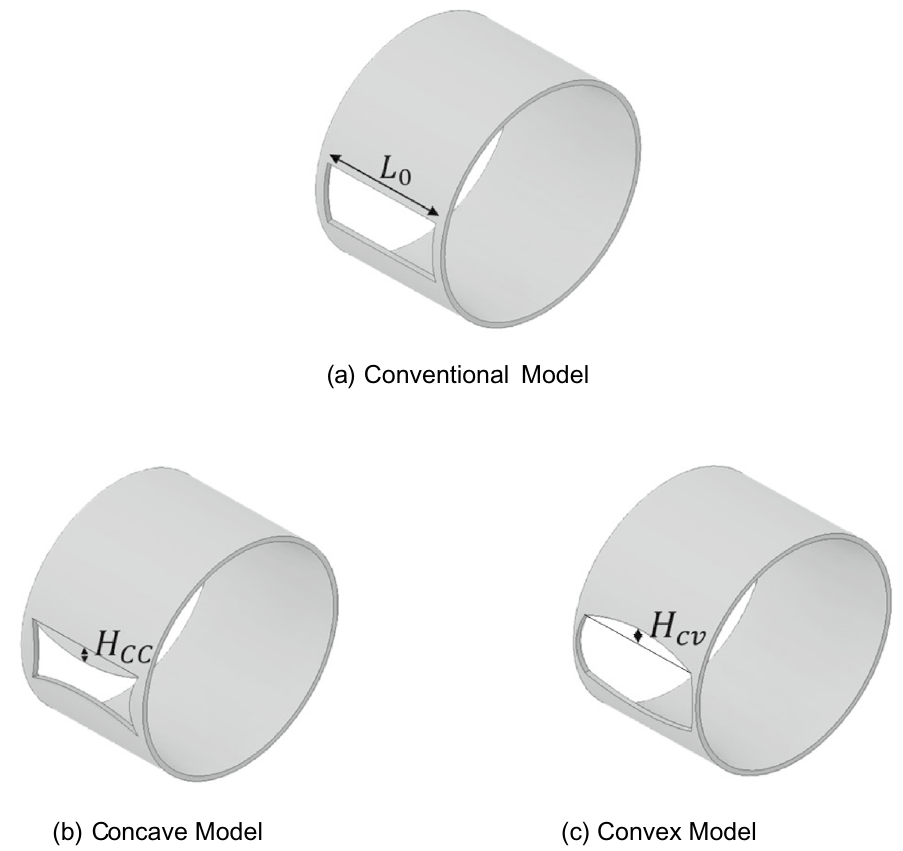
Figure 5. Proposed design of control cage (Inventor 2021, https:// www. autod esk. com/ produ cts/ inven